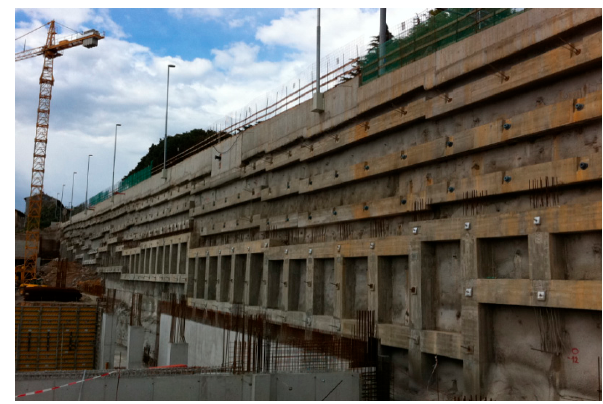
Figure 1. An example of the installed rock bolt system.